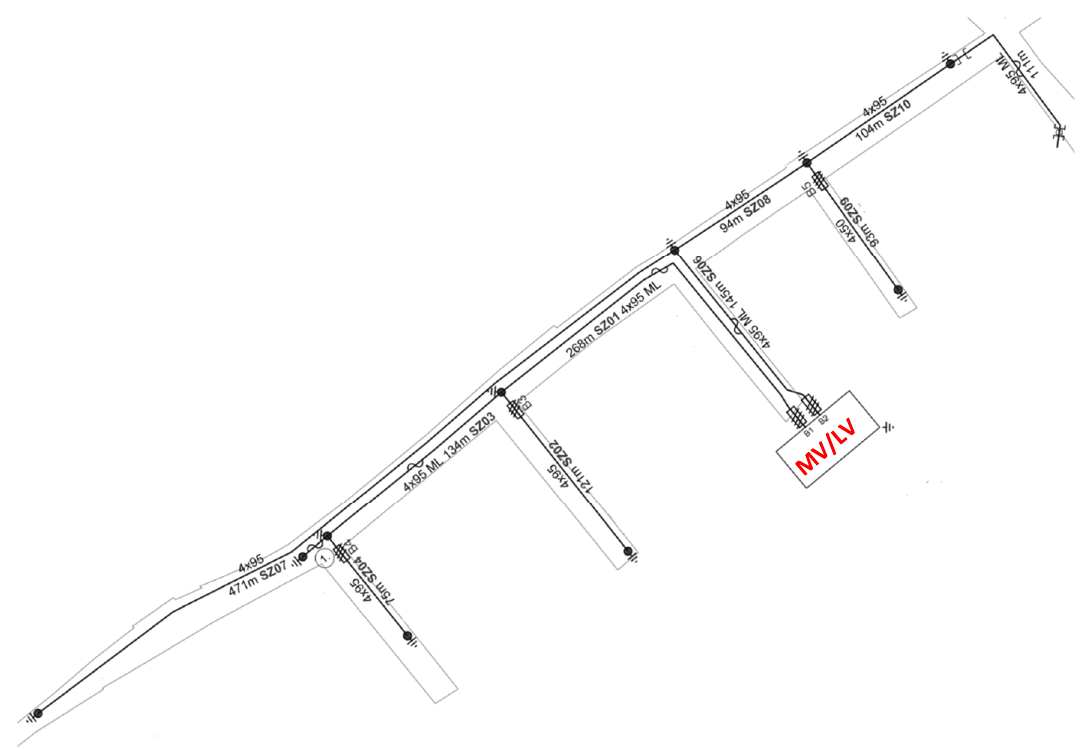
Figure A1. Topology of area 18680 (MV/LV represents the supplying medium/low-voltage trans- former).